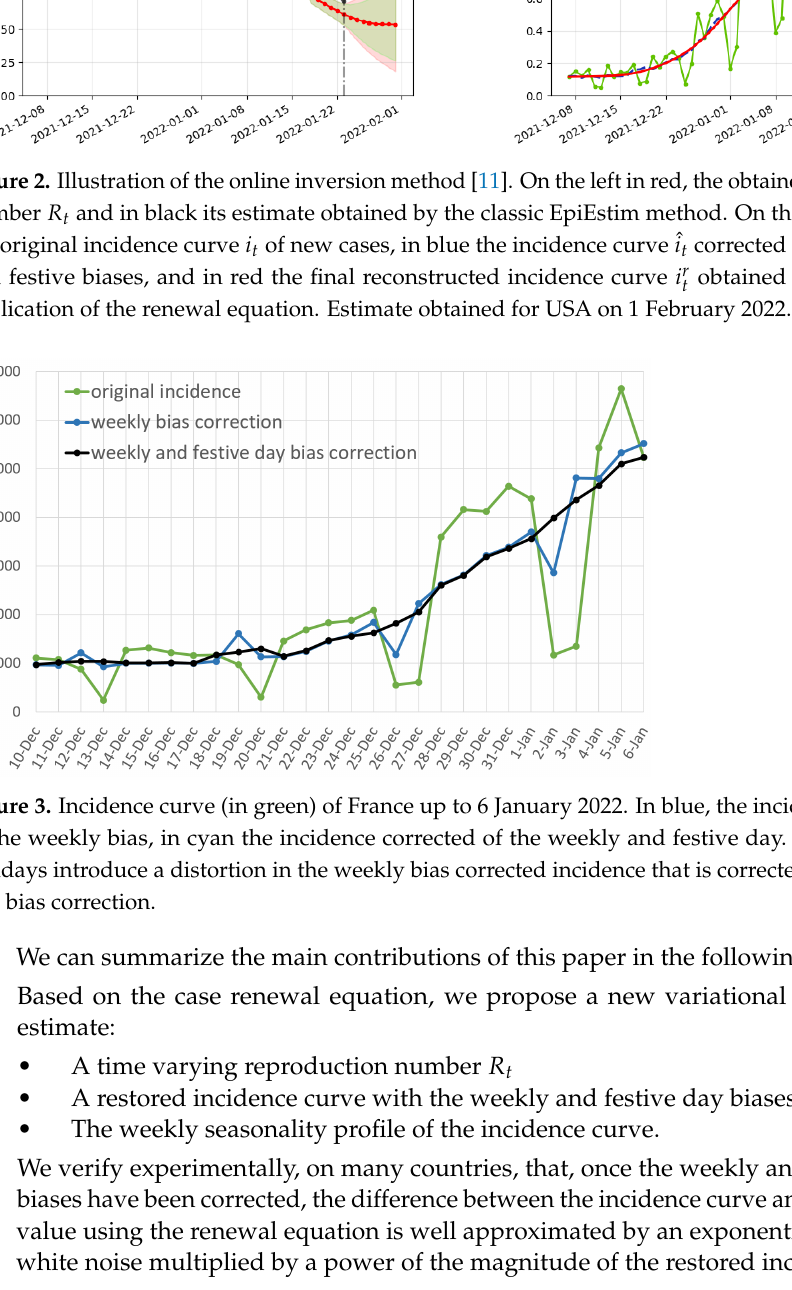
obtained from R t by the t